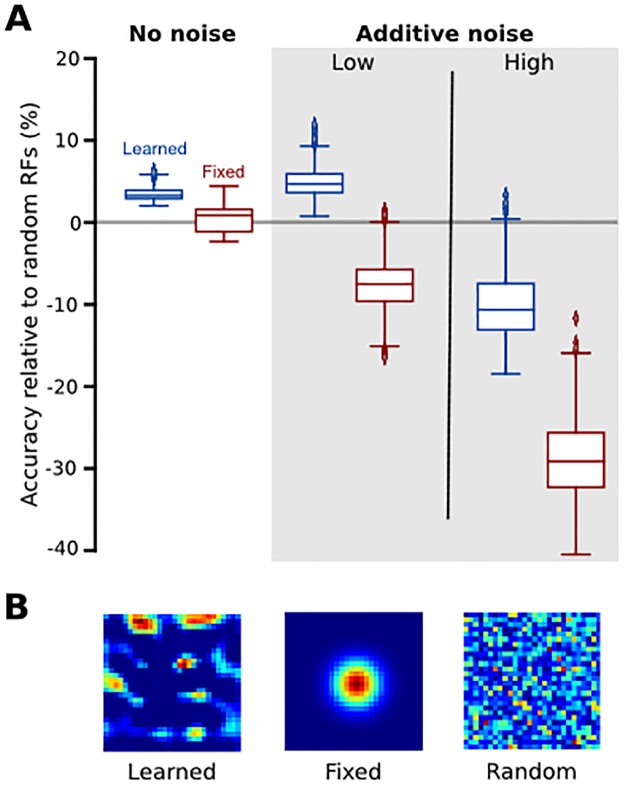
Comparison to compressed sensing framework.(A) Alphabet classification performance as a function of additive noise (same methodological details as in Fig 4b) for the 81-unit learned and fixed models, relative to a network with the same architecture but random connectivity in the first hidden layer (n = 20 for each group). Box plot represents the first and third quartiles; whiskers extend to the 95th percentile. (B) Example receptive fields from one representative unit in the learned, fixed, and the random models, respectively.